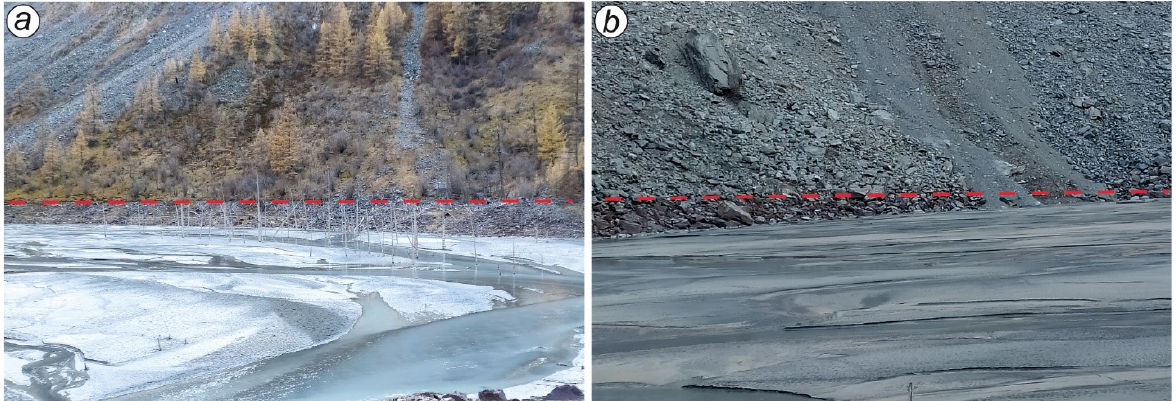
Figure 20. Photo of the high lake water levels: lack of vegetation ( a ) and coloration of stones ( b ). The red dotted line marks the lake water